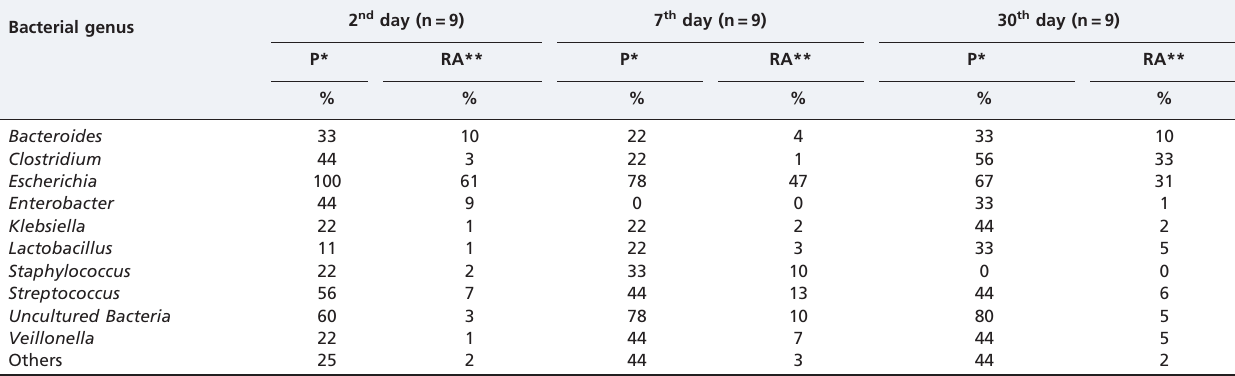
Table 3 - Relative abundances and prevalences of bacterial genera identified in fecal samples of nine neonates throughout the first month of